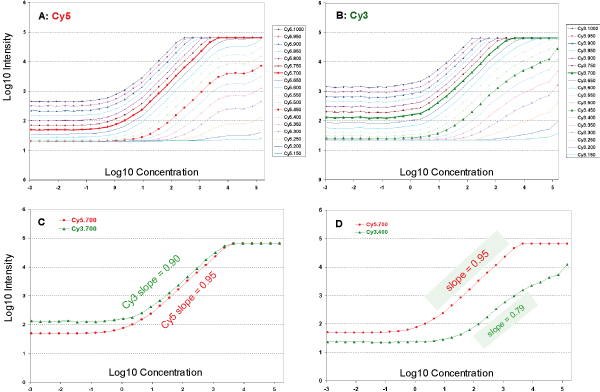
Calibration curves under different PMT gains. X-axis: log10 concentration, Y-axis: log10 fluorescence intensity. A: Cy5 dye; B: Cy3 dye. Representative calibration curves are presented in C (Cy5 and Cy3 channels are scanned under the same PMT gain of 700 V) and D (the Cy5 and Cy3 channels are scanned at 700 V and 400 V, respectively). The range of linear response between dye concentration and fluorescence intensity depends on the PMT gain, so does the slope of the linear response range. There is also a difference between Cy5 and Cy3 in terms of the spread and slope of the linear range. Each data point represents the averaged log intensity of the 12 repeats with the same dye concentration.